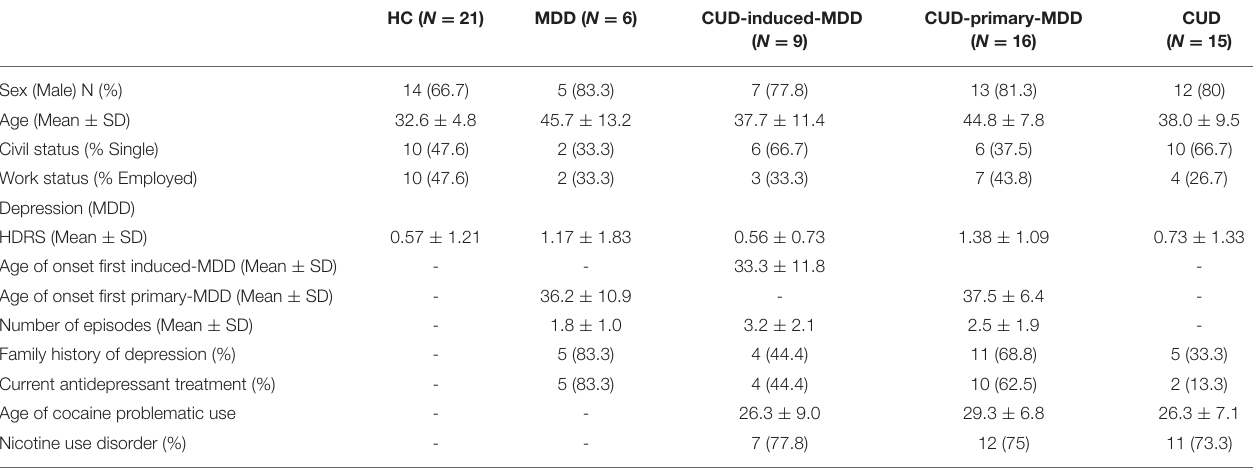
TABLE 1 | Sociodemographic and clinical characteristics of the sample at baseline ( n =